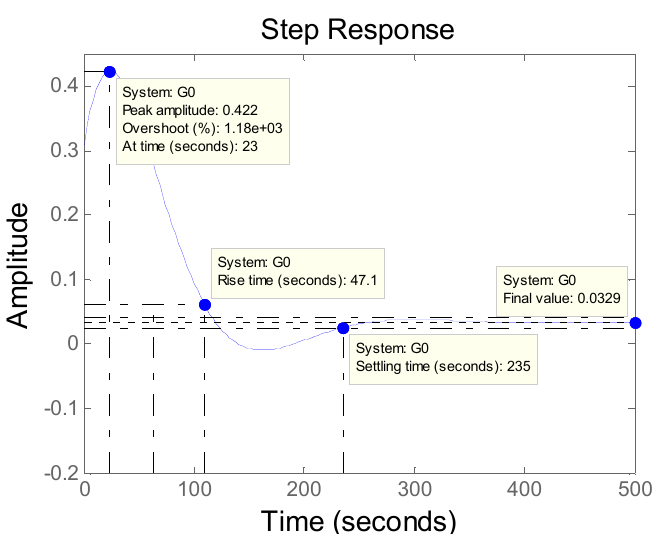
Figure 6. The dynamic performance of the transfer function.